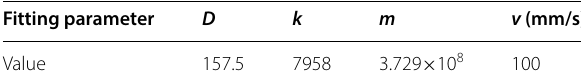
Table 3 Equation parameter of Eq.